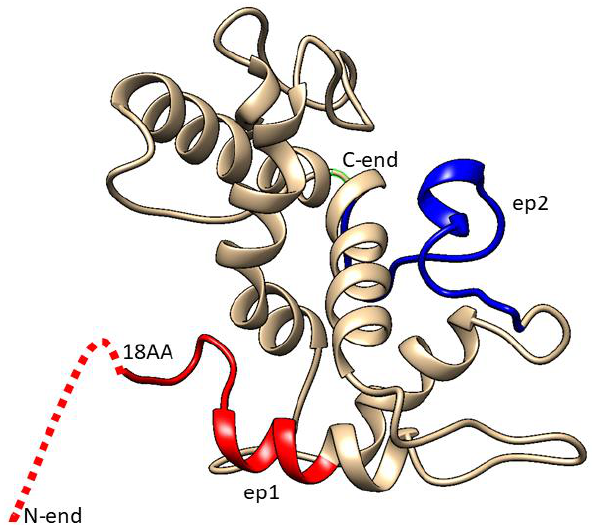
Figure 3. Three-dimensional model of surface protein p22. Red color designates ep1 , blue color desig- nates ep2 , while dashed line marks that part of the epitope whose structure could not be deter- mined.